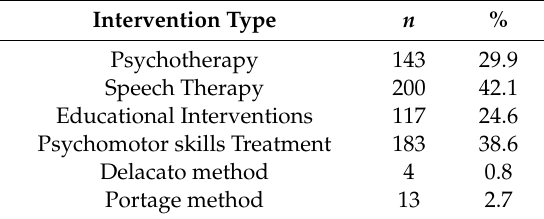
Table 6. Intervention administered during childhood and